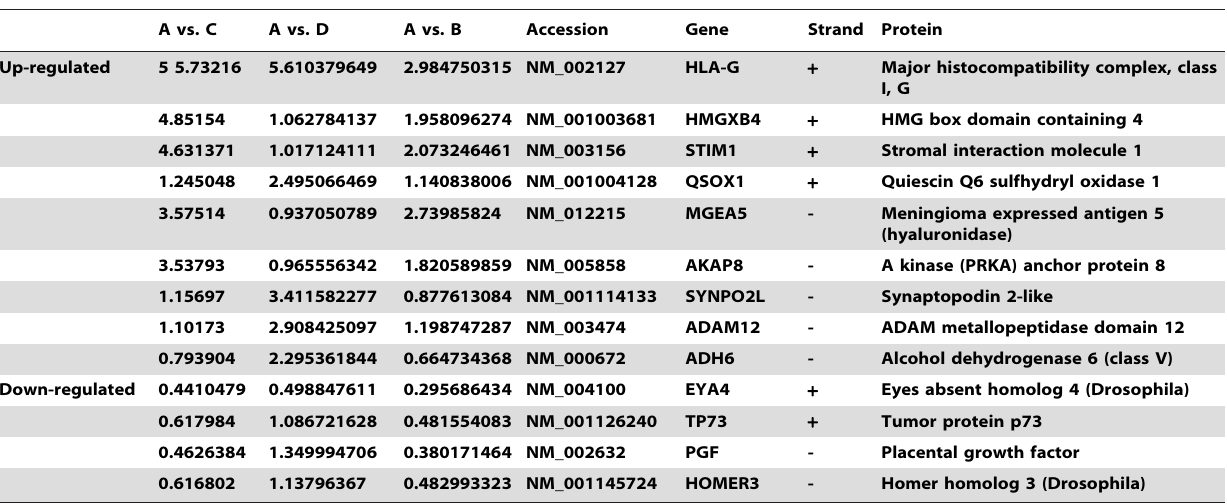
Table 5. Differentially expressed lncRNA in coding